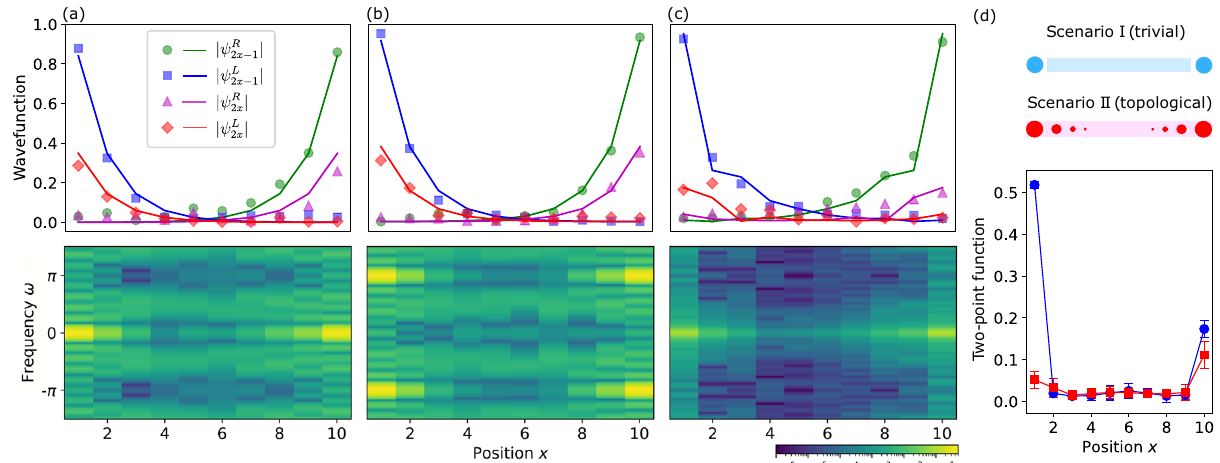
Fig. 2 | Detection of Majorana modes. Panels a – c show the absolute value of the experimentally observed Majorana mode wavefunctions ∣ ψ s μ ∣ (dots) in comparison with its theoretical prediction (lines) for N =10 qubits. Wavefunctions are further normalized because under noise effects Eq. (3) is inexact. Bottom panel illustrates the density function g ð x , ω Þ = ∣ F L 2 x (cid:2) 1 ð ω Þ ∣ 2 + ∣ F R 2 x (cid:2) 1 ð ω Þ ∣ 2 , the bright peaks show the frequency of the modes. a MZM extracted using ibm_montreal device in the topological phase θ = π /4, ϕ = π /8, and φ =0, using D =11 cycles. b MPM extracted usingthesamedeviceintopologicalphase θ = π /4, ϕ =3 π /8,and φ =0,using D =11